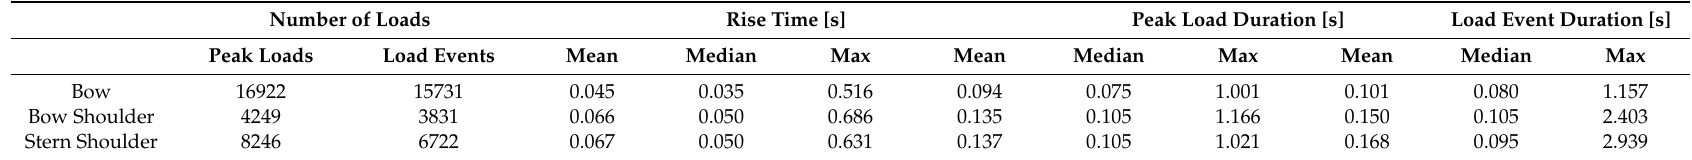
Table 10. Statistical figures for the rise time and duration of peak loads and duration of load